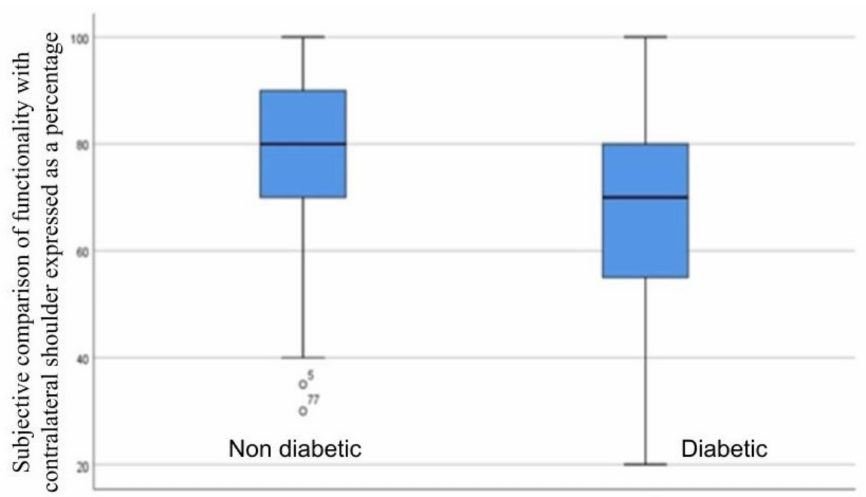
Figure 1. Mann–Whitney U test to compare shoulder function after surgery with the presence of diabetes.